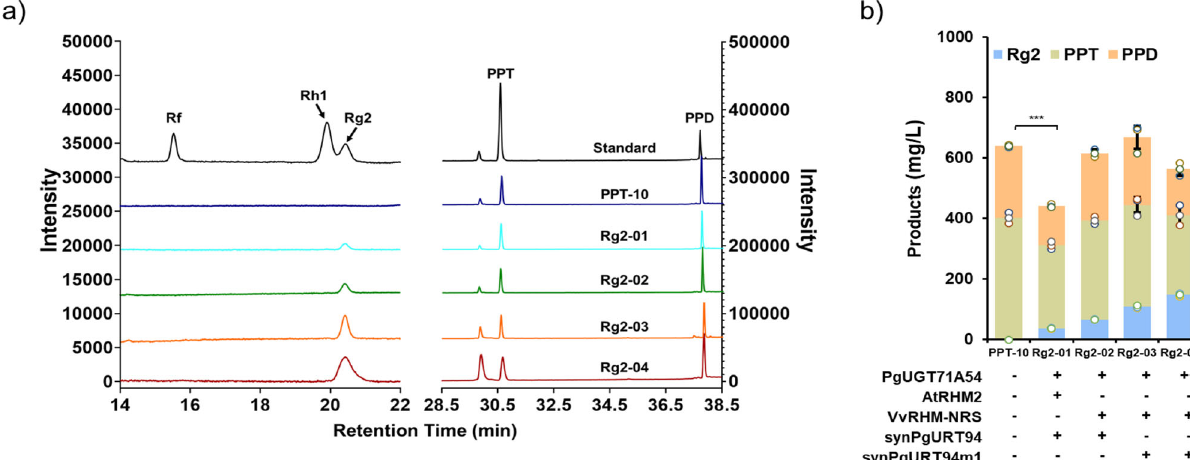
Fig. 3 Analysis of the ginsenoside Rg2 production in a engineered Saccharomyces cerevisiae strain. a HPLC analyses of Rg2, Rh1, PPT and PPD production in yeast strains Rg2-01, Rg2-02, Rg2-03, and Rg2-04. The PPT chassis strain PPT-10 was used as a control. Mixed samples of Rf, Rh1, Rg2, PPT and PPD were monitored as standards. b Quantitative analysis of Rg2 and its related intermediates Rh1, PPT, and PPD in yeast strains Rg2-01, Rg2-02, Rg2- 03, and Rg2-04. Genetic modi fi cation of each strain was drawn under the column, “ + ” represent the strain possess the corresponding engineering, while “ − ” represent the corresponding engineering are missing the strain. All data represent the mean of n = 3 biologically independent samples and error bars show standard